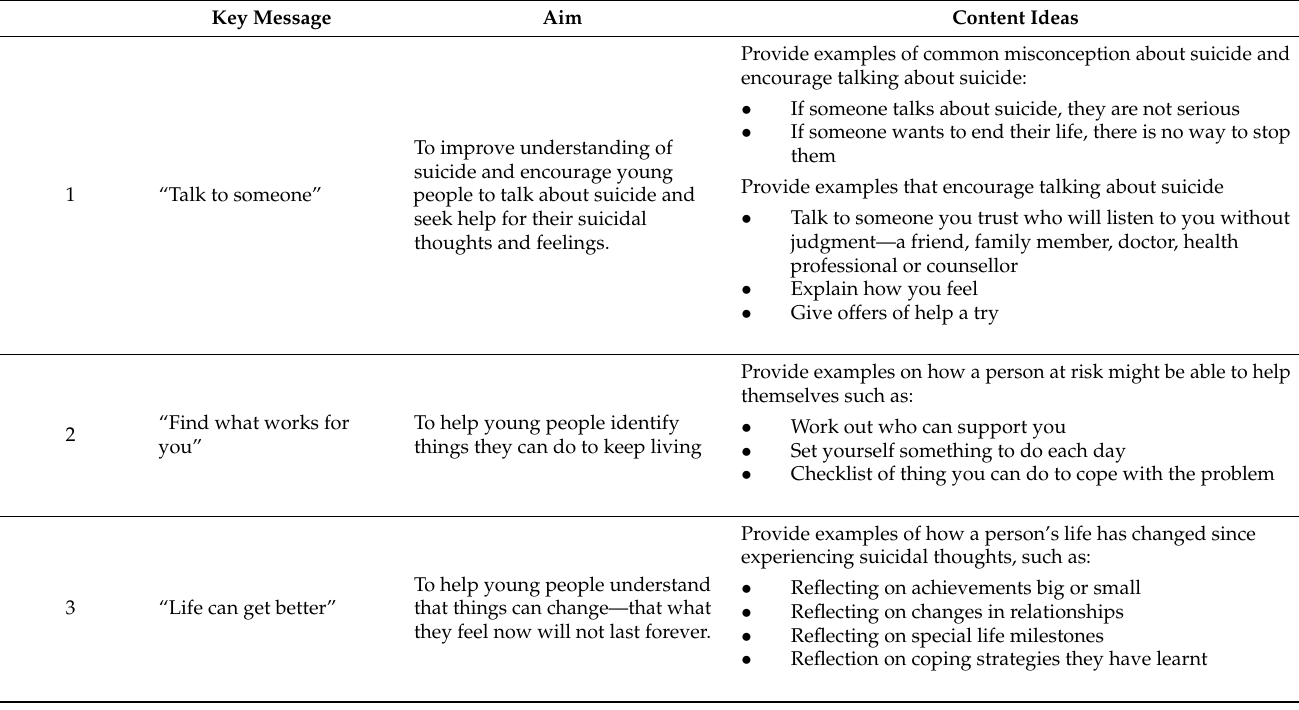
Table 1. Preliminary suicide prevention